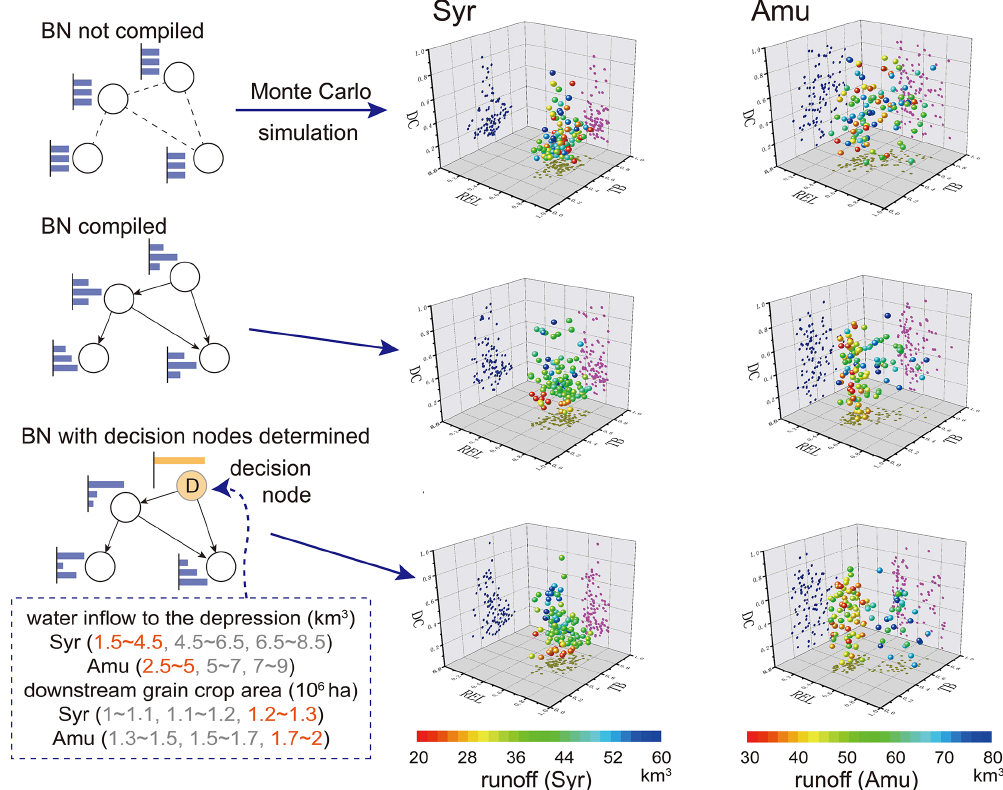
Figure 9. Comparison of multi-criteria evaluation of the SDB and ADB based on the BN causality constraint-based MCMC sampling. At the top is the multi-criteria evaluation based on random sampling with no joint probability included, in the middle is the multi-criteria assessment containing the BN causality constraints and the bottom is based on the BN with nodes for optimization and decision